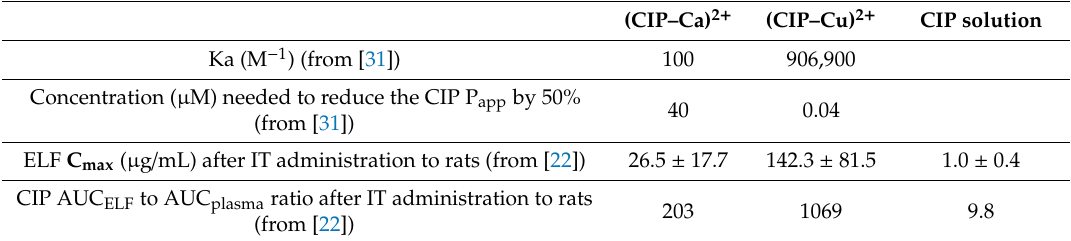
Table 4. The relationship between the a ffi nity of the complex formed between CIP and the metal cation and pulmonary exposure to CIP after IT administration of the